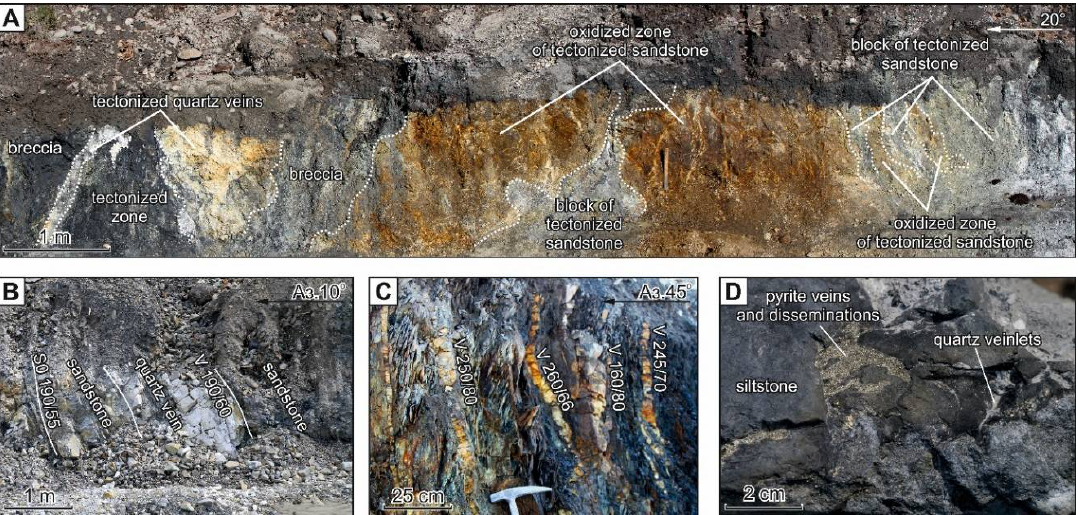
Figure 2. Khangalas Fault ( A ) and types of mineralization in the Khangalas ore cluster (KOC): ( B ) concordant veins, Centralnaya zone of the Khangalas deposit; ( C ) vein-veinlet mineralization; ( D ) veinlet-disseminated mineralization.